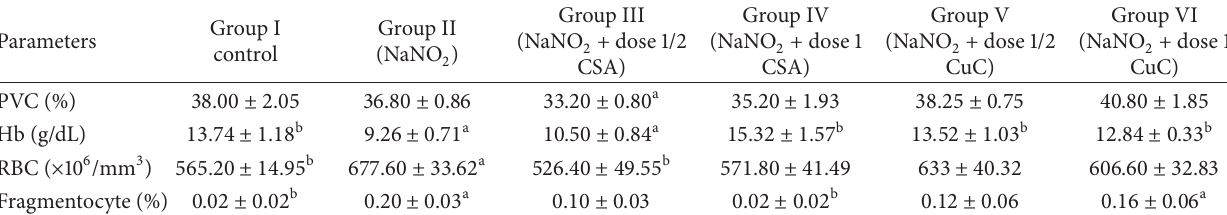
Table 1: The hematological parameters in each experimental